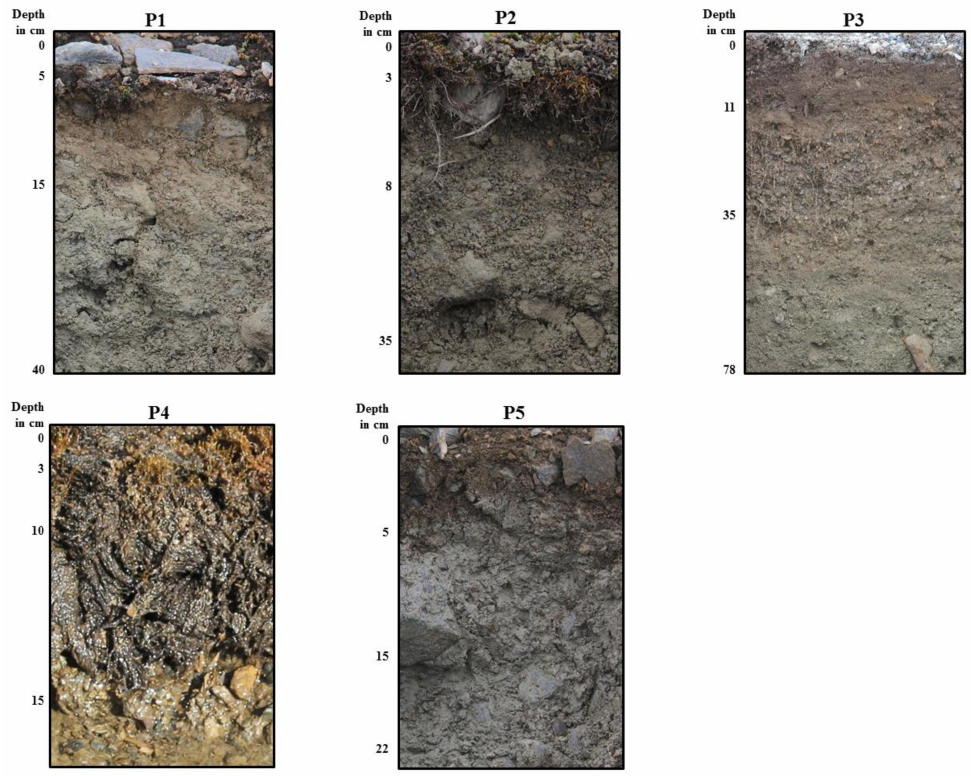
Figure 2. Photographs of analysed soil